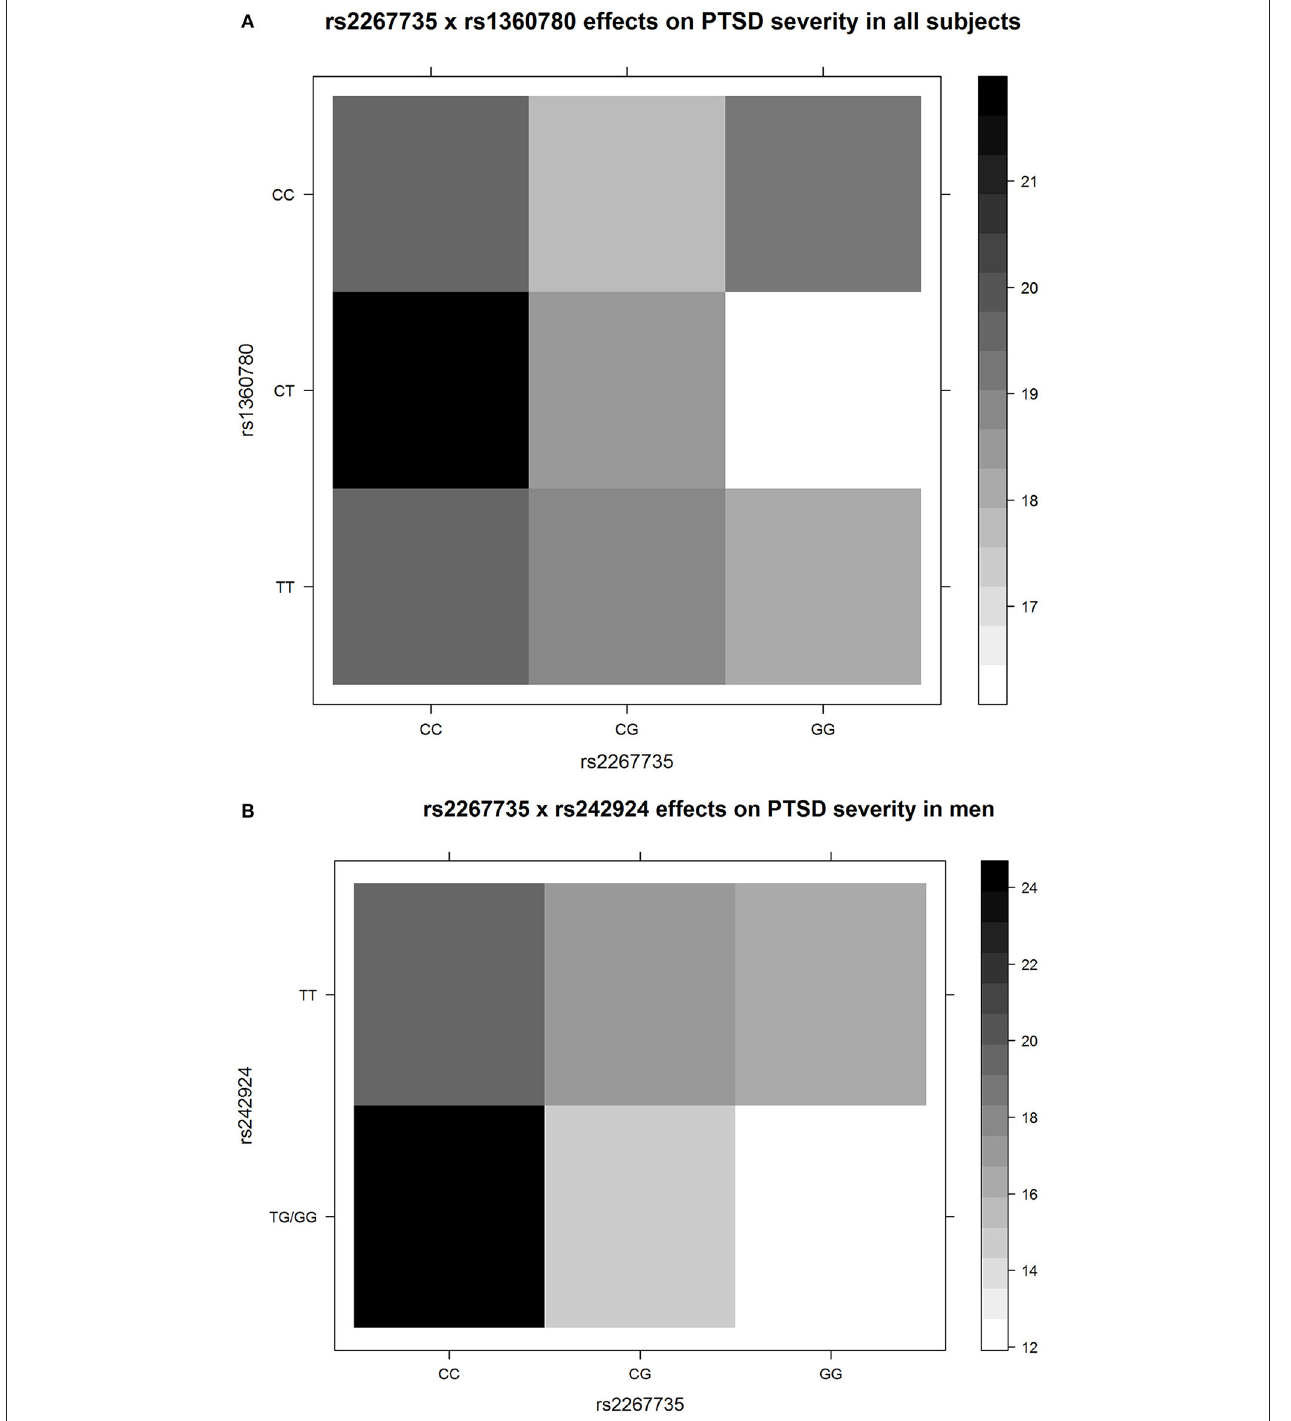
FIGURE 1 | The G × G (epistasis) effects represented by the distributions of posttraumatic stress disorder (PTSD) severity across genotype combinations. The colors of each unit were filled according to the means of PTSD severity of the subjects with the corresponding specific genotype combinations. The upper panel (A) shows rs2267735 × rs1360780 for all subjects, and the lower panel (B) shows rs2267735 × rs242924 for men. Only three men had the rs242924 genotype GG; thus, we merged GG and TG. The figures directly show epistasis. For example, in (A) , for the subjects with rs1360780 genotype CC, the minor allele G of rs2267735 is not correlated to PTSD severity; for the subjects with rs1360780 genotypes CT and TT, the minor allele G of rs2267735 corresponds to decreased PTSD severity, with different effect sizes. The figures were drawn by R3.4.4.